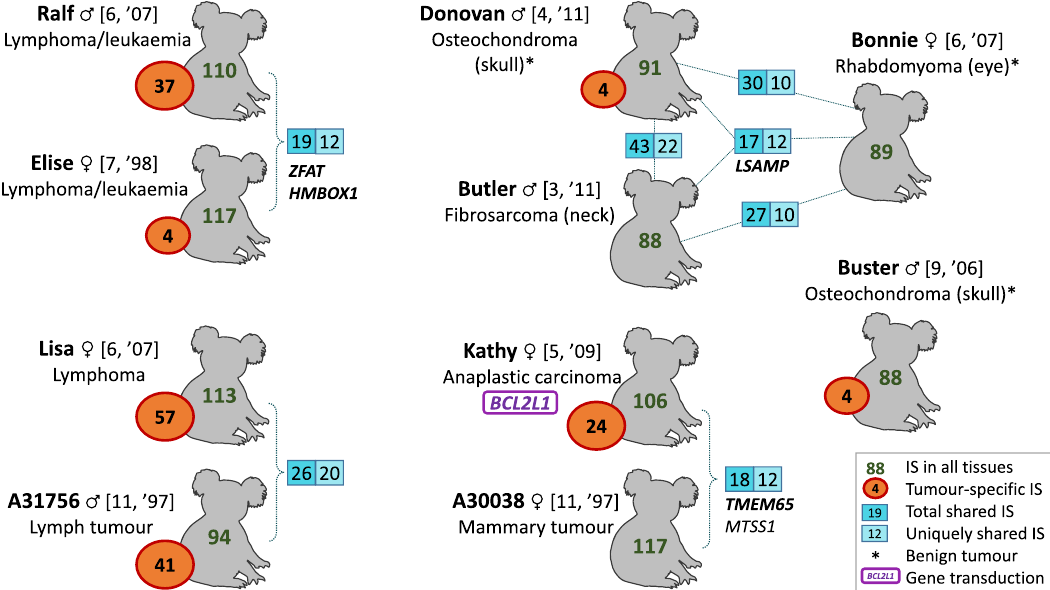
Fig. 1 Overview of IS detected in healthy and tumour tissues of ten koalas. The name and sex of each koala is given, with age and year of birth in square brackets (age and year of birth are estimated from tooth wear). Number of IS detected in all tissues are shown in green for each koala and represent ERVs, whereas tumour-speci fi c IS (shown in orange circles) represent somatic integrations in tumour tissues. Koalas sharing many IS are grouped (see Fig. 3), with the numbers of shared IS given in blue boxes (dark blue = total IS shared, including IS shared with other koalas; light blue = IS shared only between given koalas; lines connect koalas that share IS and do not represent speci fi c family relationships). Outside of these groups, koalas share nine or fewer IS. Examples of genes containing IS shared only between indicated koalas are given (with genes containing IS in exons shown in